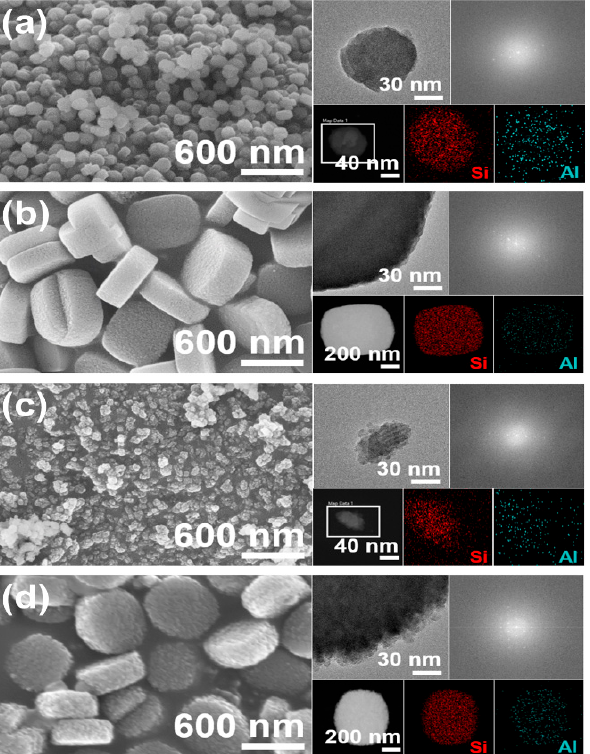
Figure 2. Morphologies of Silicalite-1@Al-ZSM-5 zeolites with different sizes and SARs. FE-SEM, FE-TEM, and EDS images of ( a ) 100 nm_SAR 140, ( b ) 800 nm_SAR 140, ( c ) 80 nm_SAR 35, and ( d ) 600 nm_SAR 35. The synthesis sol composition was 4050 H 2 O:4.5 TPAOH:20 SiO 2 :x Al 2 O 3 :2x NaOH, where x = 0.07 and 0.29. After the addition of the silicalite-1 seeds, the weight ratio of Silicalite-1 nanocrystals and TEOS = 3.62 × 10 − 2 wt%. The synthesis was conducted at 150 °C for 24 h. Si and Al were marked in red and sky blue, respectively.